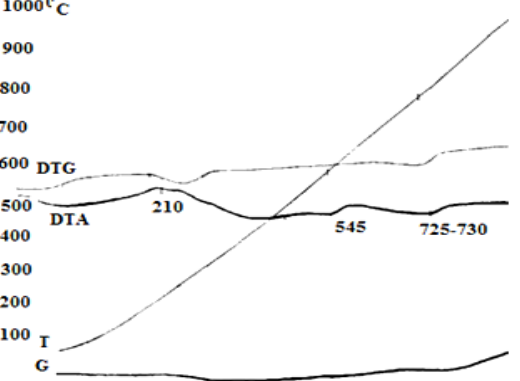
Fig. 1. DTA/TG curves of the Kharganat iron ore